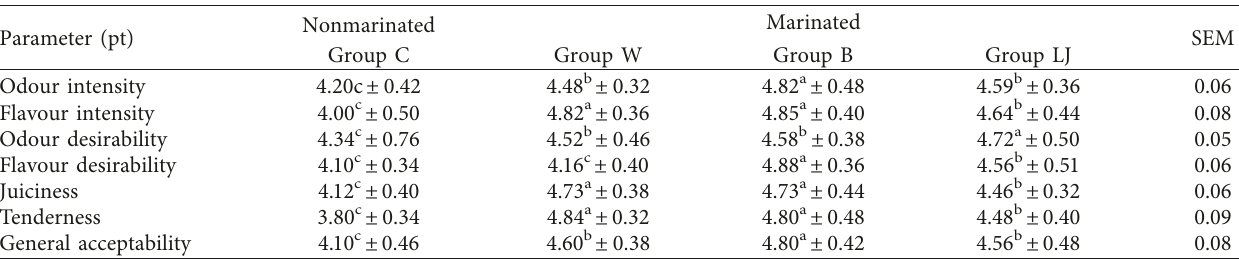
Table 4: Sensory properties of nonmarinated and marinated roasting breast muscles of slaughter pheasants. Parameter